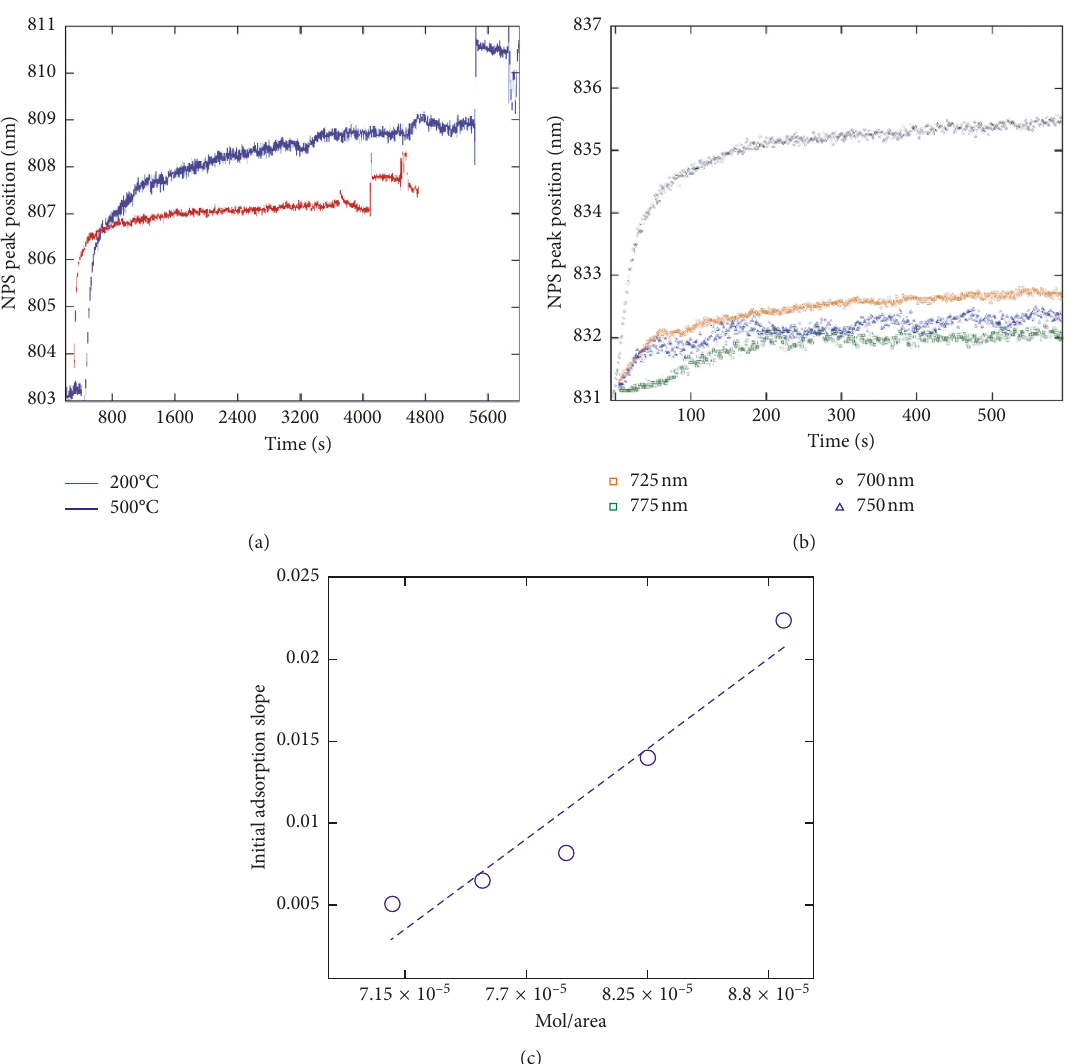
Figure 4: (a) Nanoplasmonic peak shifts upon injection of N719 dye into TiO (b) Nanoplasmonic peak shifts of N719 dye in TiO 2 photoelectrodes of varying thicknesses from 700nm to 775nm. (c) Initial dye adsorption slope of the thinner films (700 nm film removed from